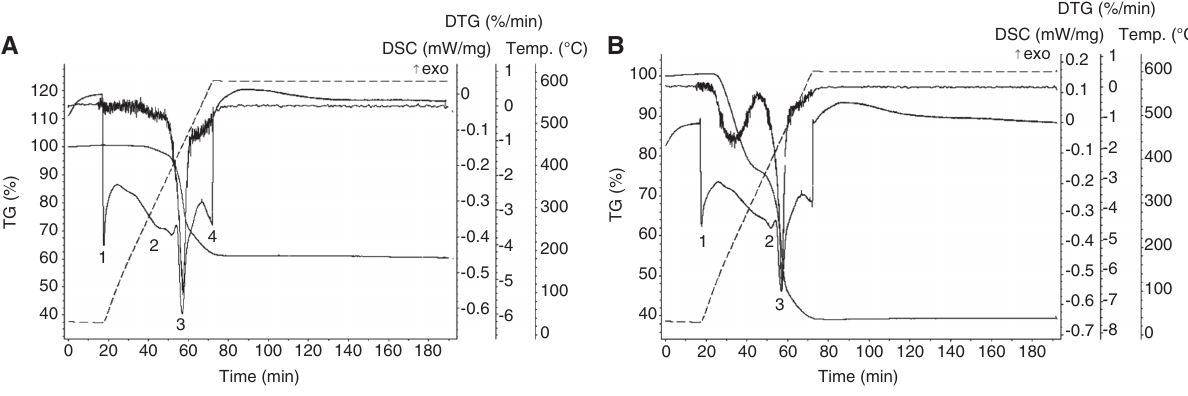
Figure 2 TGA curves of 1%-Pd/HPS catalyst before (A) and after (B)